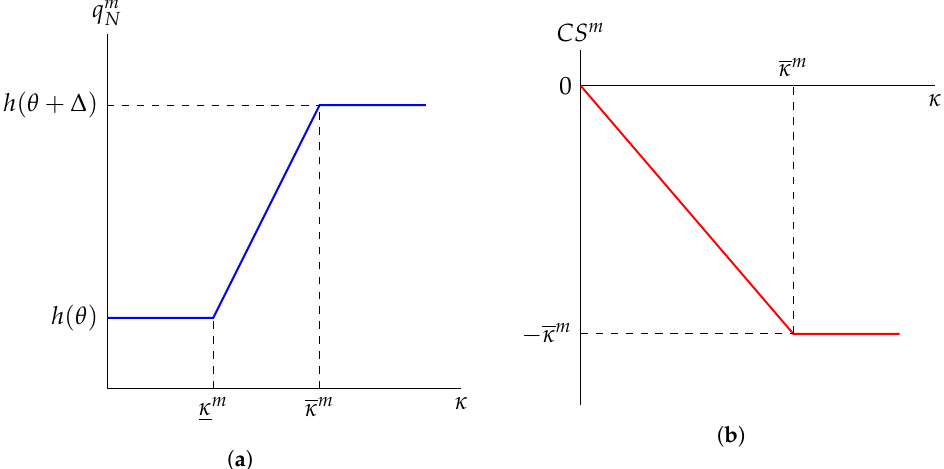
Figure 1. Graphical depiction of the cognitive equilibrium outcome under monopoly. Panel ( a ) displays how good provision, q m , varies with cognitive cost κ , while panel ( b ) displays how N consumer surplus, CS m , varies with cognitive cost κ